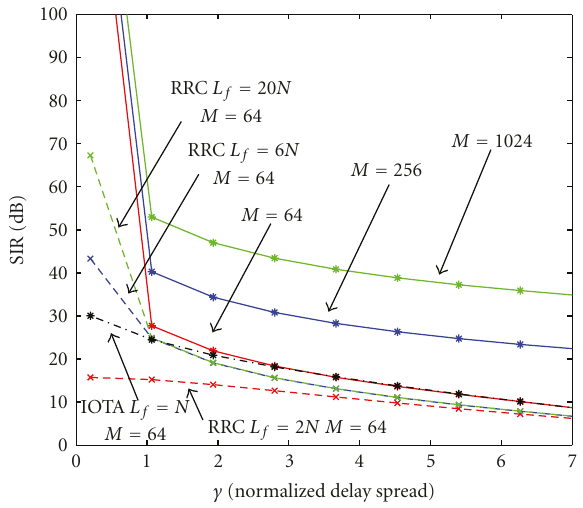
Figure 15: SIR versus the normalized delay spread γ for orthogonal pulse with (solid lines) M 0 = 8, N 0 = 9, and L f = N .